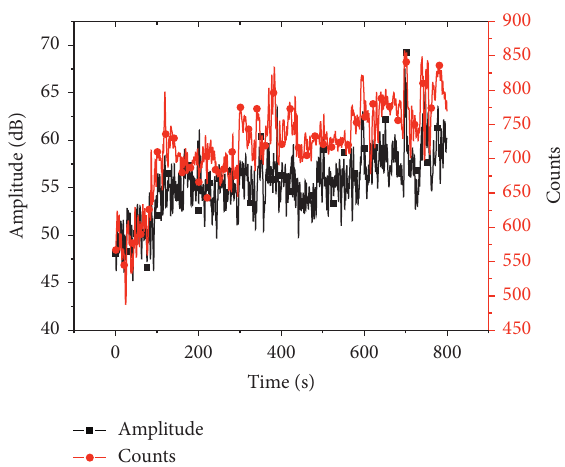
Figure 9: The trends of amplitude and counts during degradation.